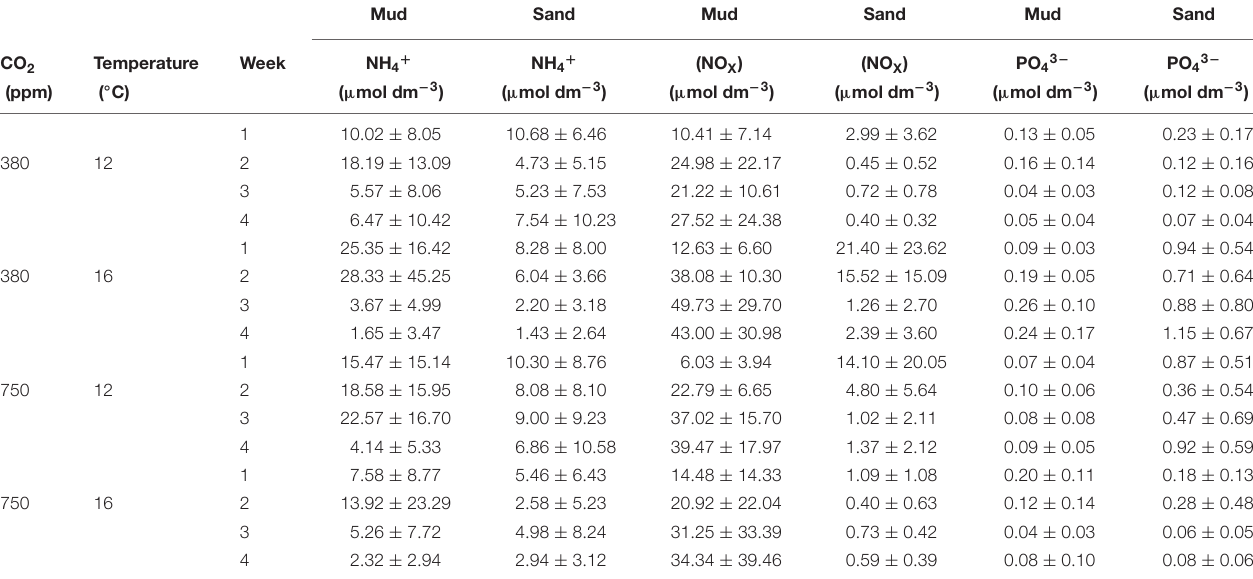
TABLE 1 | Mean nutrient concentrations ( ± standard deviation of mean) for ammonium (NH 4 + ), nitrite + nitrate (NO X ), and phosphate (PO 43 − ) recorded in the overlying water taken weekly in each environmental treatment for muddy and sandy sediments. Mud Sand Mud Sand Mud Sand Week NH 4